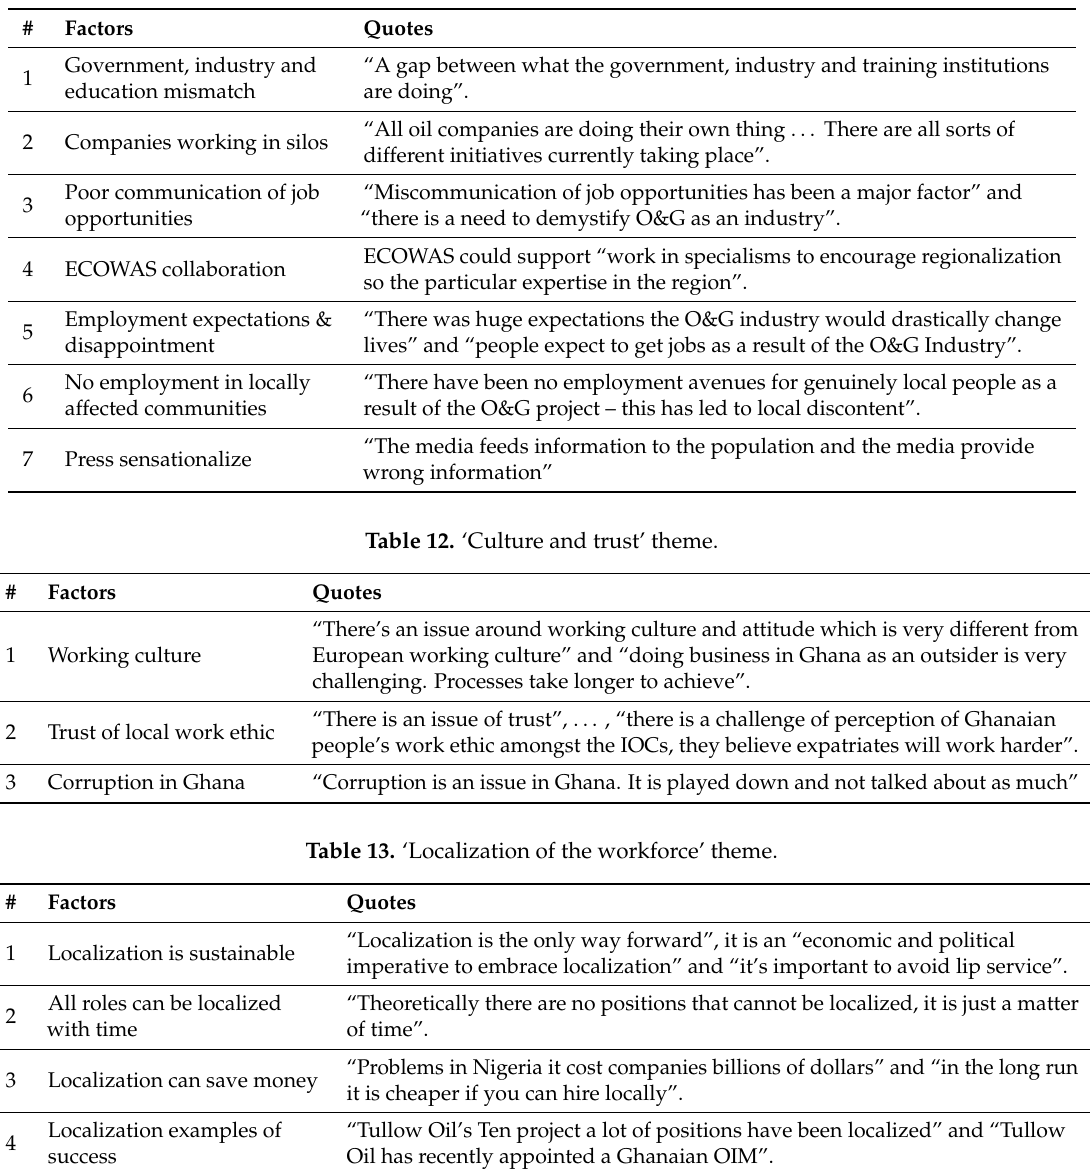
Table 11. ‘Collaboration, communication & expectation management’ theme.